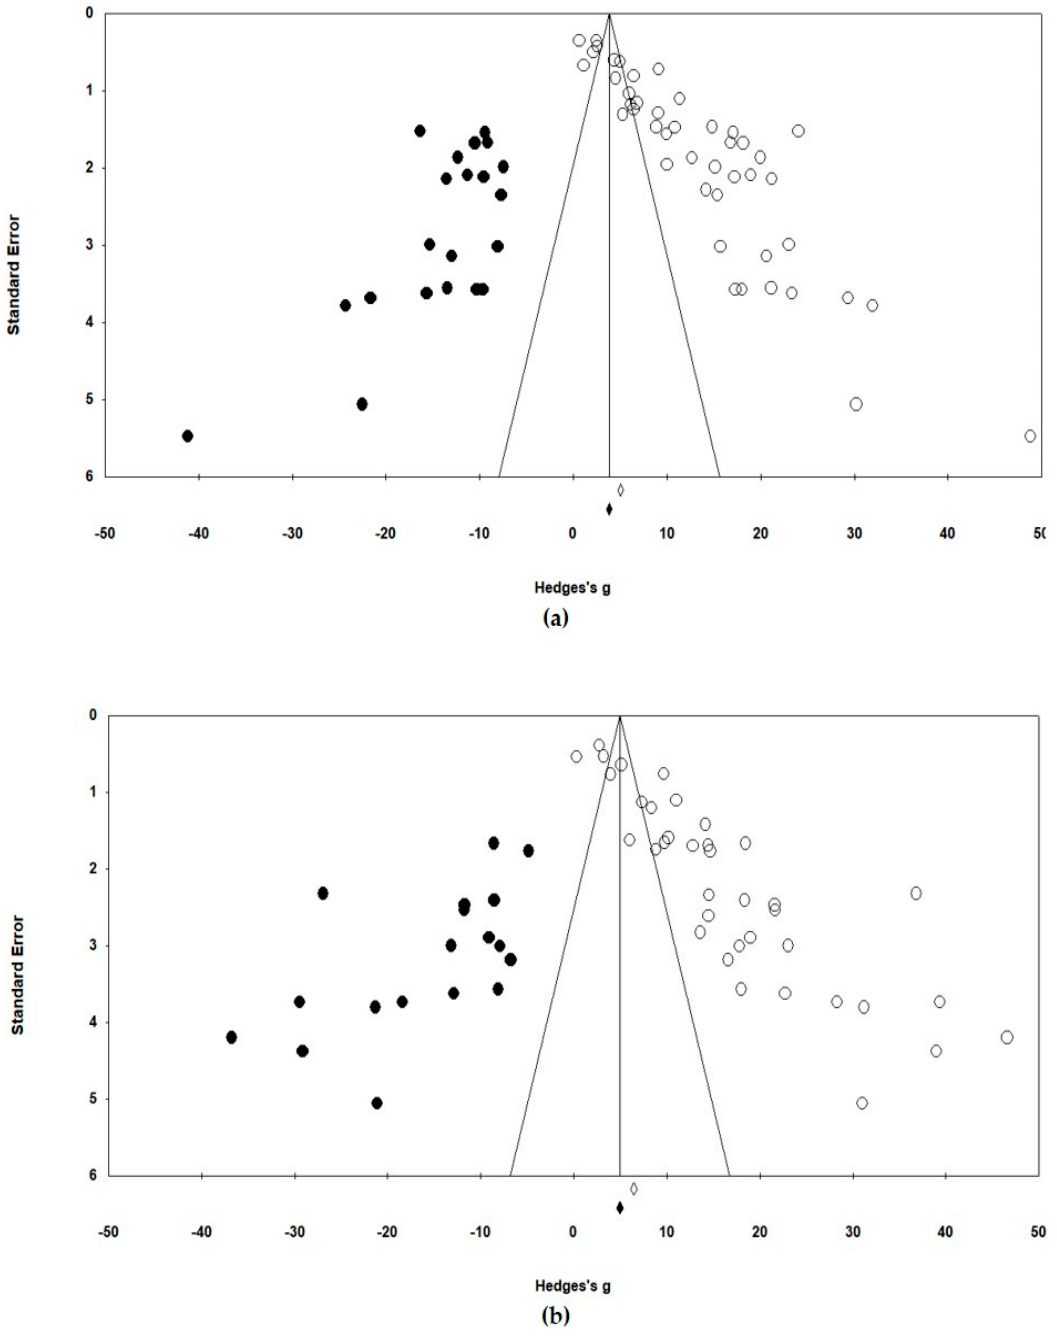
Figure 3. ( a ) Funnel plot on cognition; ( b ) Funnel plot on Figure 3. (a) Funnel plot on cognition; (b) Funnel plot on depression.